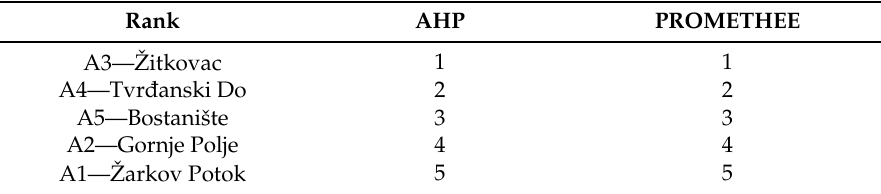
Table 12. The rank of solutions according to the AHP and PROMETHEE